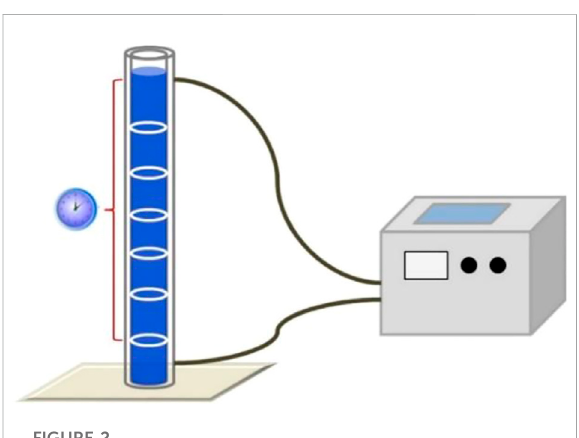
FIGURE 2 Schematic diagram of the experimental apparatus.